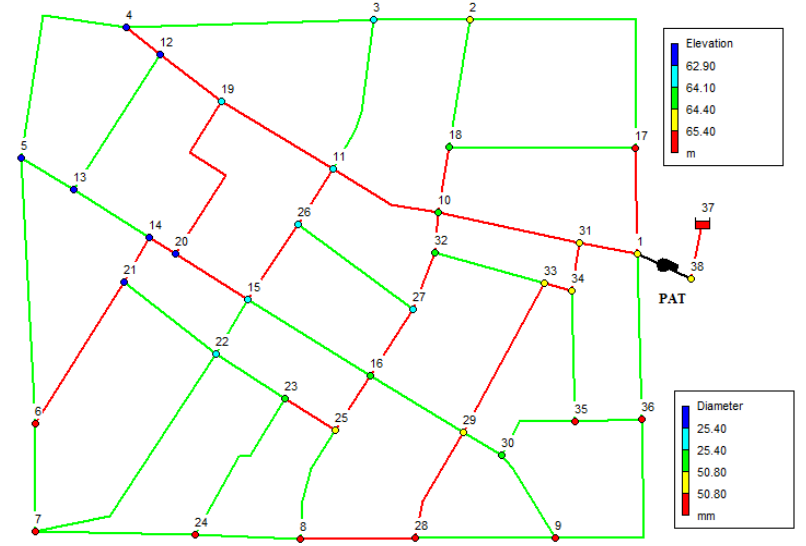
Figure 6. Fossolo network and PAT location.